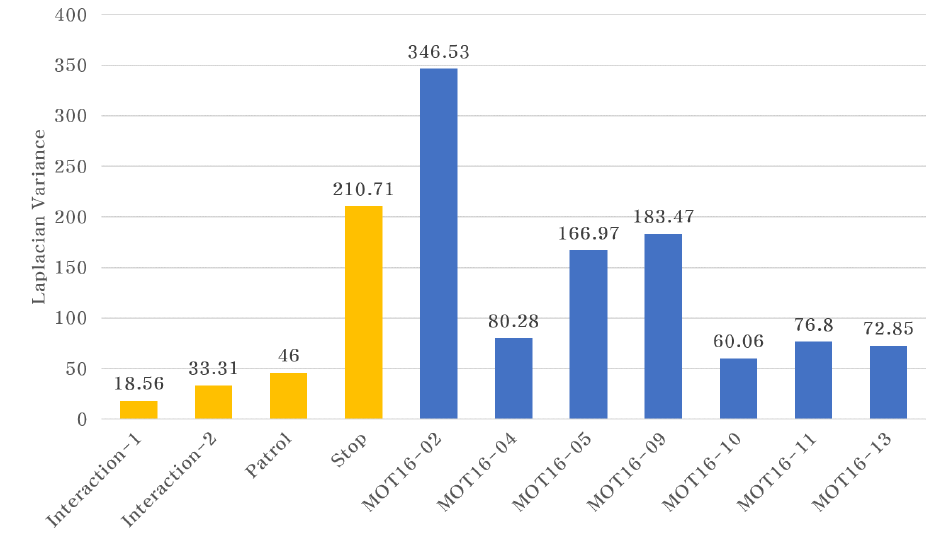
Figure 8. Measured Laplacian variances of each dataset. The horizontal and vertical axis represents the dataset and the averaged value of the Laplacian variance for each dataset, respectively.